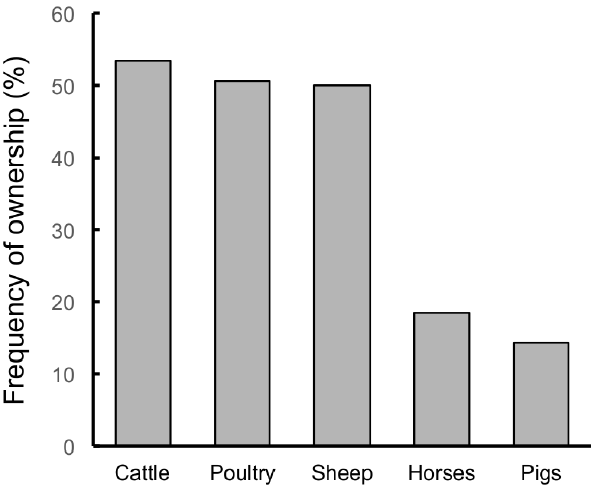
Figure 2. Farm animal ownership. Farm animal ownership in rural households around three protected areas in southern Chile.